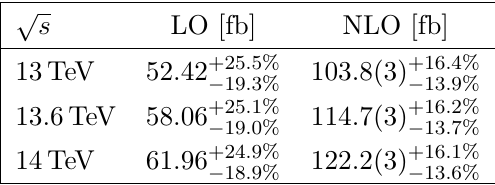
Table 1. Total cross sections at LO and NLO with full top-quark mass dependence, evaluated at the scale µ = µ = m . The upper and lower values resulting from a 7-point scale variation by R F ZH a factor of two are also shown.